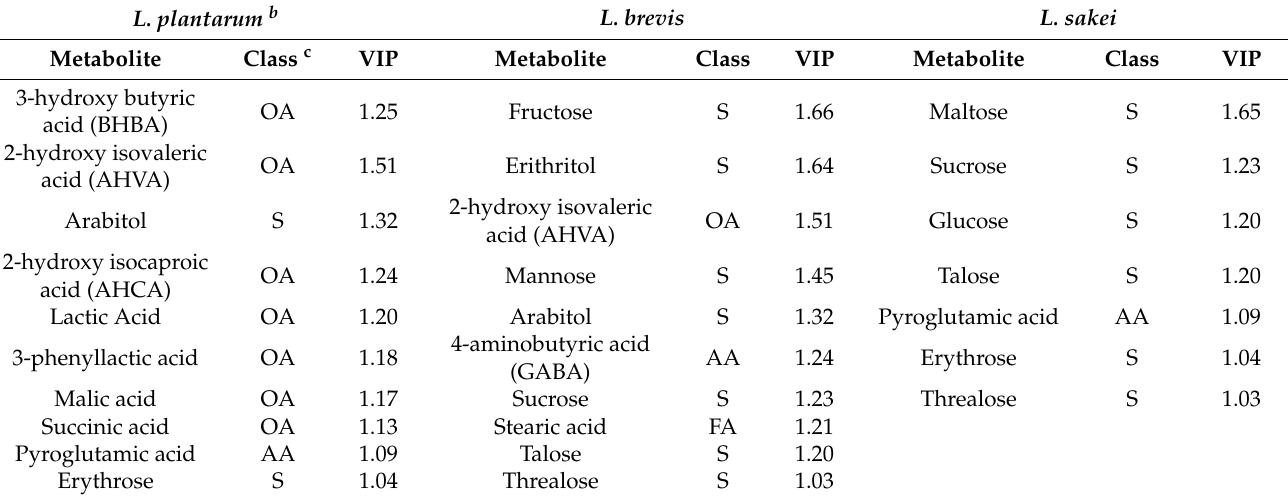
Figure 1. PLS-DA of GC-MS data, R 2 Y = 0.93 and Q 2 Y = 0.88, over 2 validated components. ( a ) score plot ( Lb , Lp , and Ls = L. brevis , L. plantaris , and L. sakei , respectively); ( b ) loading plot, red hexagons = organic acids; green circles = amino acids; light blue stars = saccharides and polyols; yellow circles = fatty acids and analogues; black diamond = loadings of Lactobacillus classes. Unknown metabolites are not displayed. Metabolites are abbreviated as in Table S2. Table 2. PLS-DA VIP a scores of discriminant GC-MS